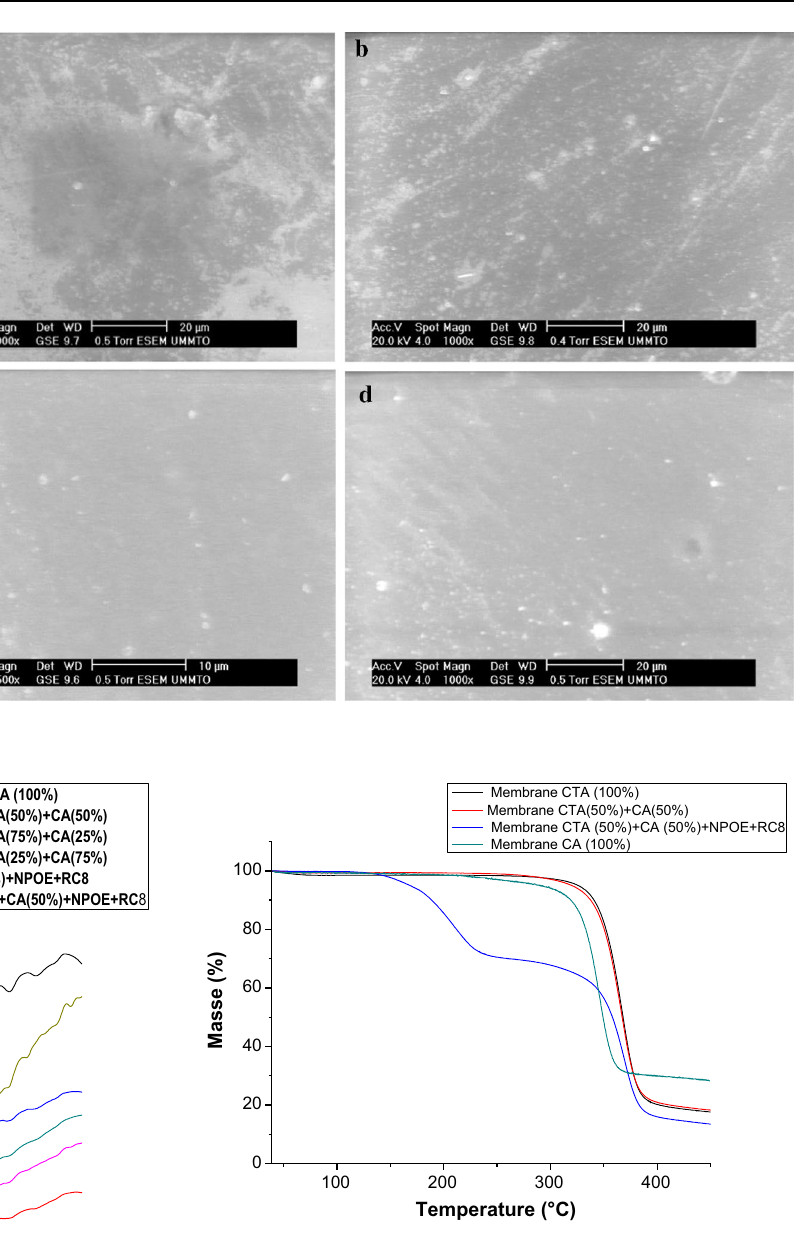
Fig. 5 Thermograms analysis of developed